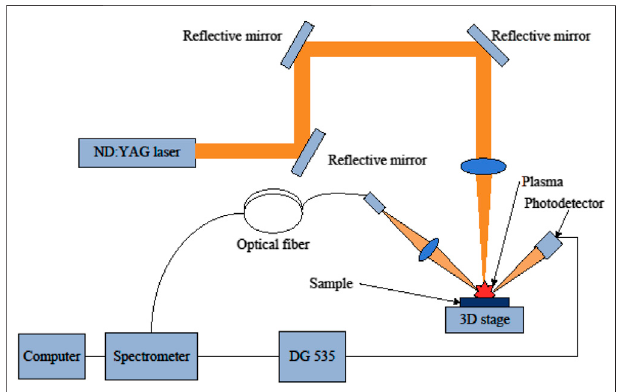
FIGURE 1 | Experimental LIBS